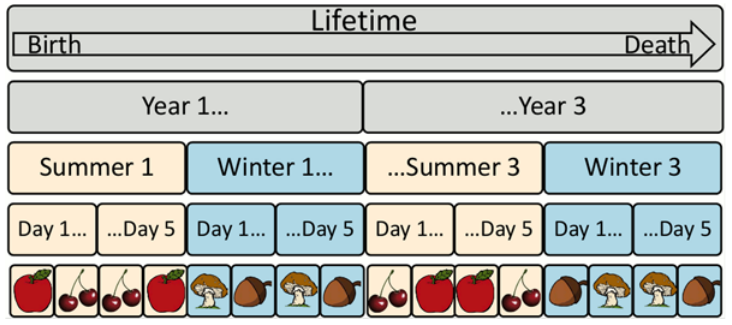
Fig 2. The environment for one individual ’ s lifetime. A lifetime lasts 3 years. Each year has 2 seasons: winter and summer. Each season consists of 5 days. In each day, each individual sees all food items available in that season (only two are shown) in a random order.